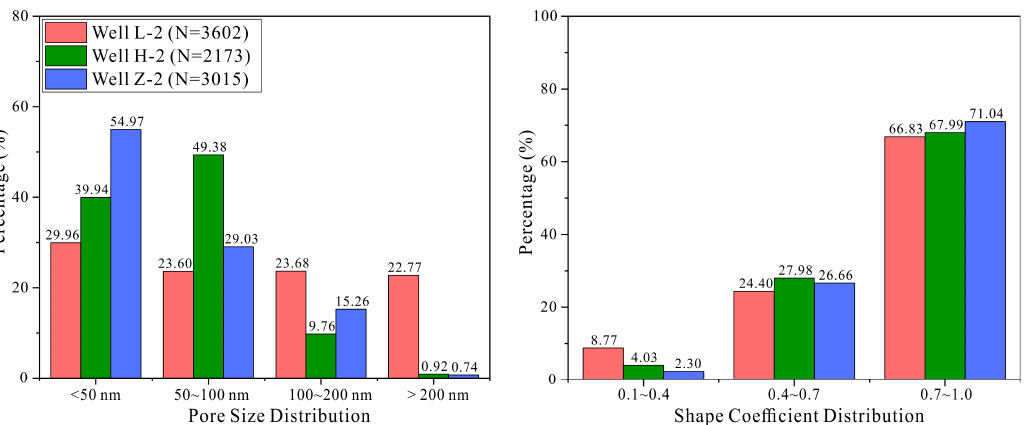
Figure 11. Based on FIB-SEM image analysis, comparing the structural characteristics of organic pores in the Mbr 1 1 of Longmaxi Fm shale with different pressure coefficients. A higher proportion of organic macropores occur in shale reservoirs with a higher pressure coefficient. However, no differences are presented in shape coefficient distribution, illustrating the positive impact of the pressure coefficient on the pore size distribution of organic pores and the limited impact on pore morphology. N represents the total number of organic pores counted.